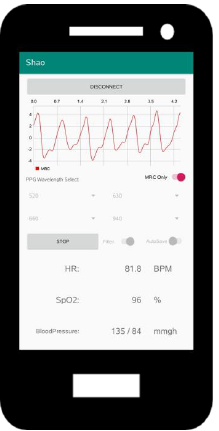
Figure 4. The developed mobile app.